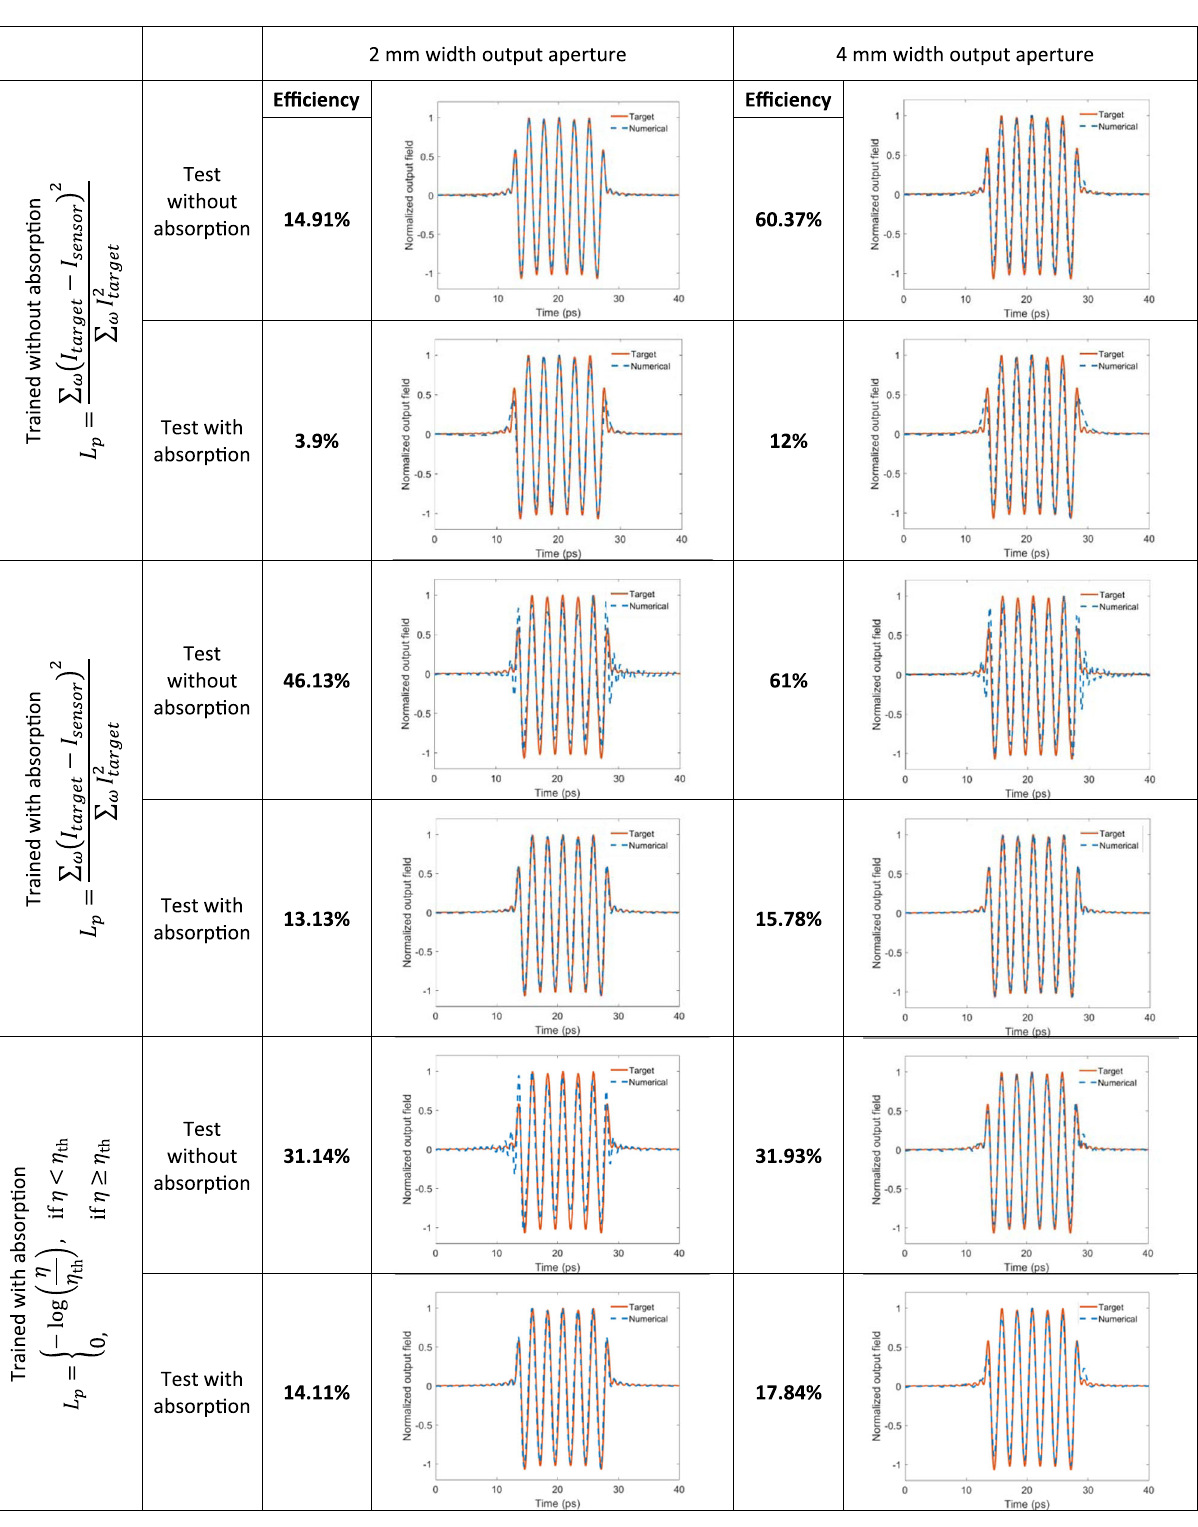
Fig. 6 Power ef fi ciency values of pulse shaping diffractive networks trained with different loss functions. These diffractive pulse shaping networks were trained to generate a 15.5 ps square pulse with output aperture widths of 2 mm (left) and 4 mm (right), with their corresponding loss functions shown in the leftmost